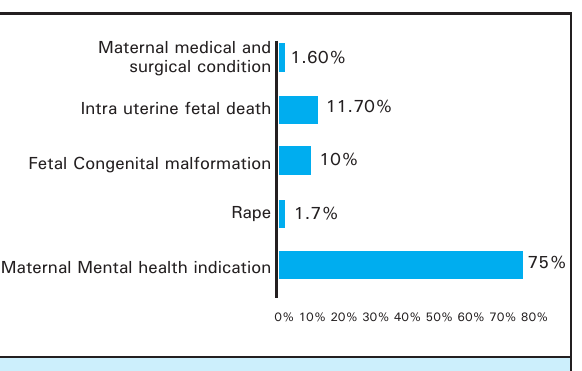
Figure 2. Indication for termination of pregnancy.